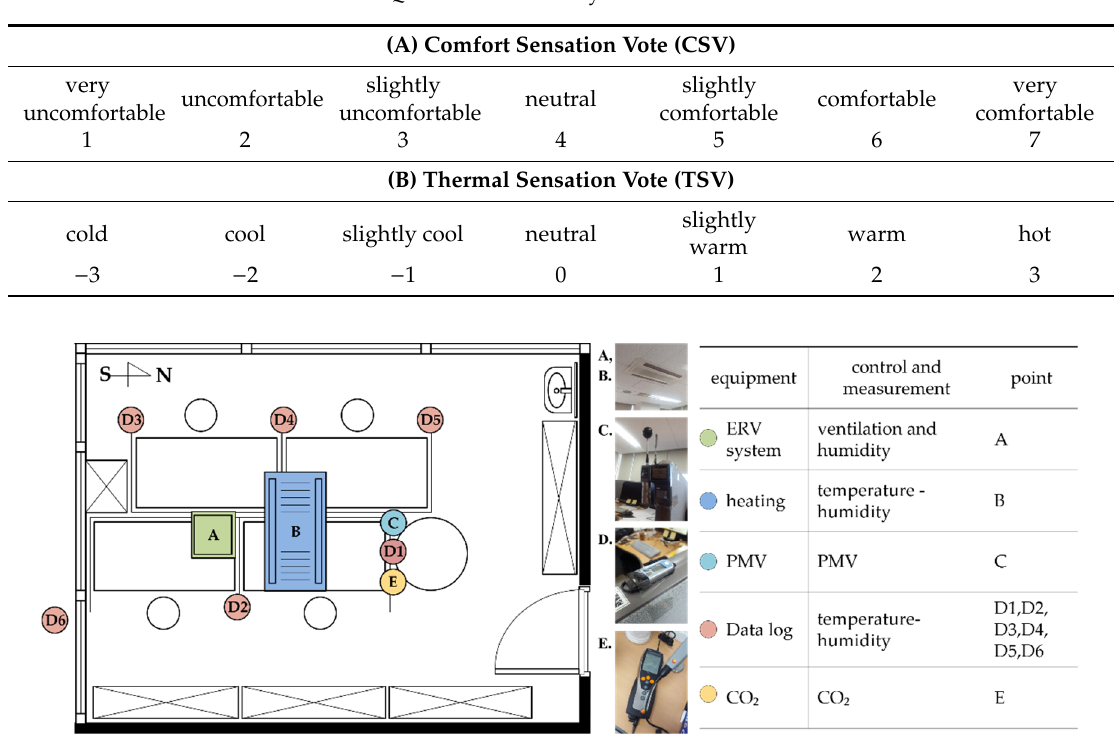
Figure 2. Installation position of the measuring Figure 1. Installation position of the measuring apparatus.